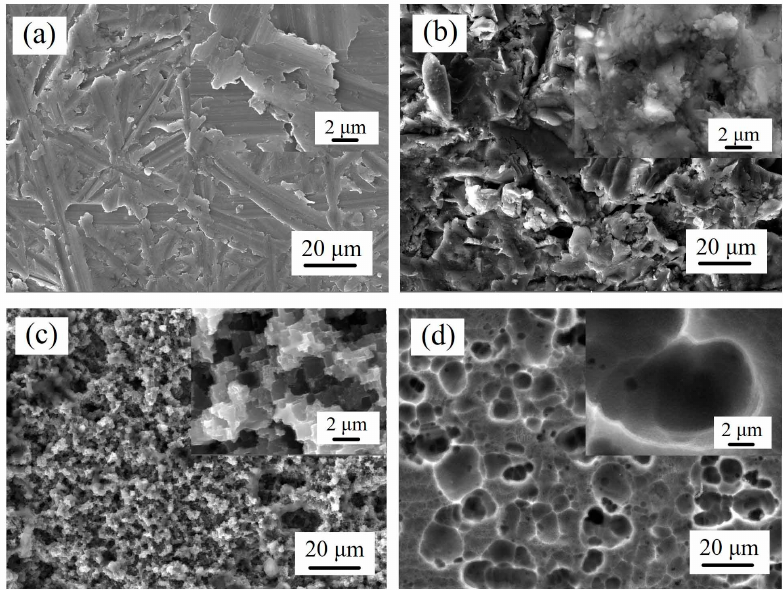
Figure 2. Surface morphologies with different treatments: ( a ) sandpaper abrading, ( b ) sandblasting, ( c ) chemical etching, and ( d ) PAA.